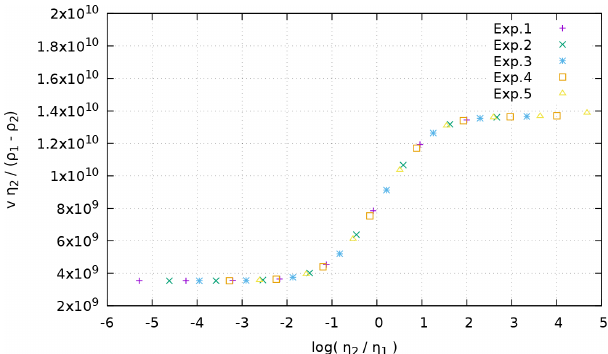
Figure B2. Velocity measurements as a function of the viscosity contrast between surrounding medium and block for the experi- ments of the falling block